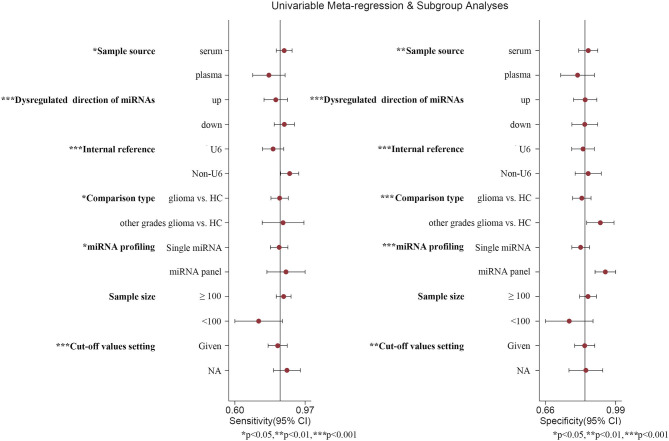
Meta-regression analysis. *, **, and *** represent P < 0.05, P < 0.01, and P < 0.001, respectively.